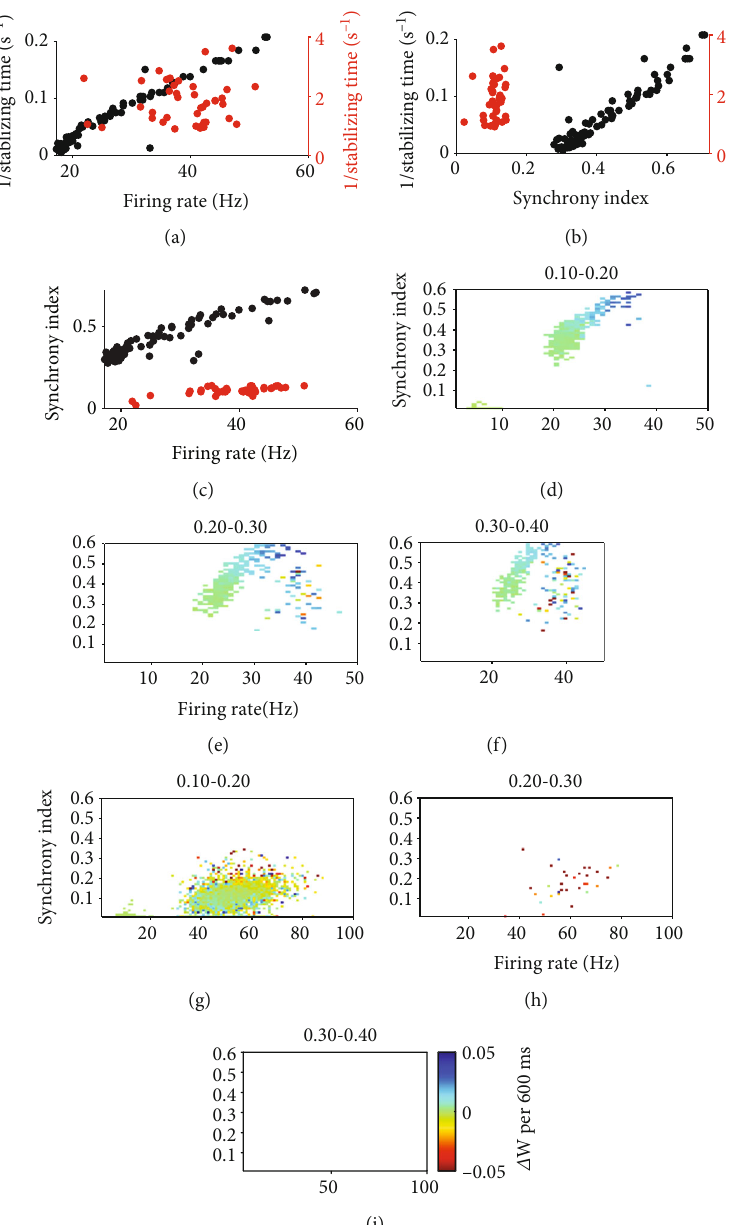
Figure 5: The process of synaptic stabilizing in circuits with plasticity. (a) The relation between stabilizing time and fi ring rate. (b) The relation between stabilizing time and synchrony index. (c) The relation between fi ring rate and synchrony index. In (a – c), black/red dots are results under synchronous/asynchronous dynamics. (d – i) The relationship between the change of synaptic weight with respect to the instantaneous fi ring rate and synchrony index during the simulation. The studied ranges of synaptic weight are shown as title above the sub fi gures. (d – f) Under synchronous dynamics with τ E = 3, 4, 5 ⋯ 9ms . (g – i) Under asynchronous dynamics with τ E = 20, 30, 40 ⋯ 90ms . d d = 8ms Other parameters are As = 2, 2 : 5, 3, 3 : 5 : and τ I d